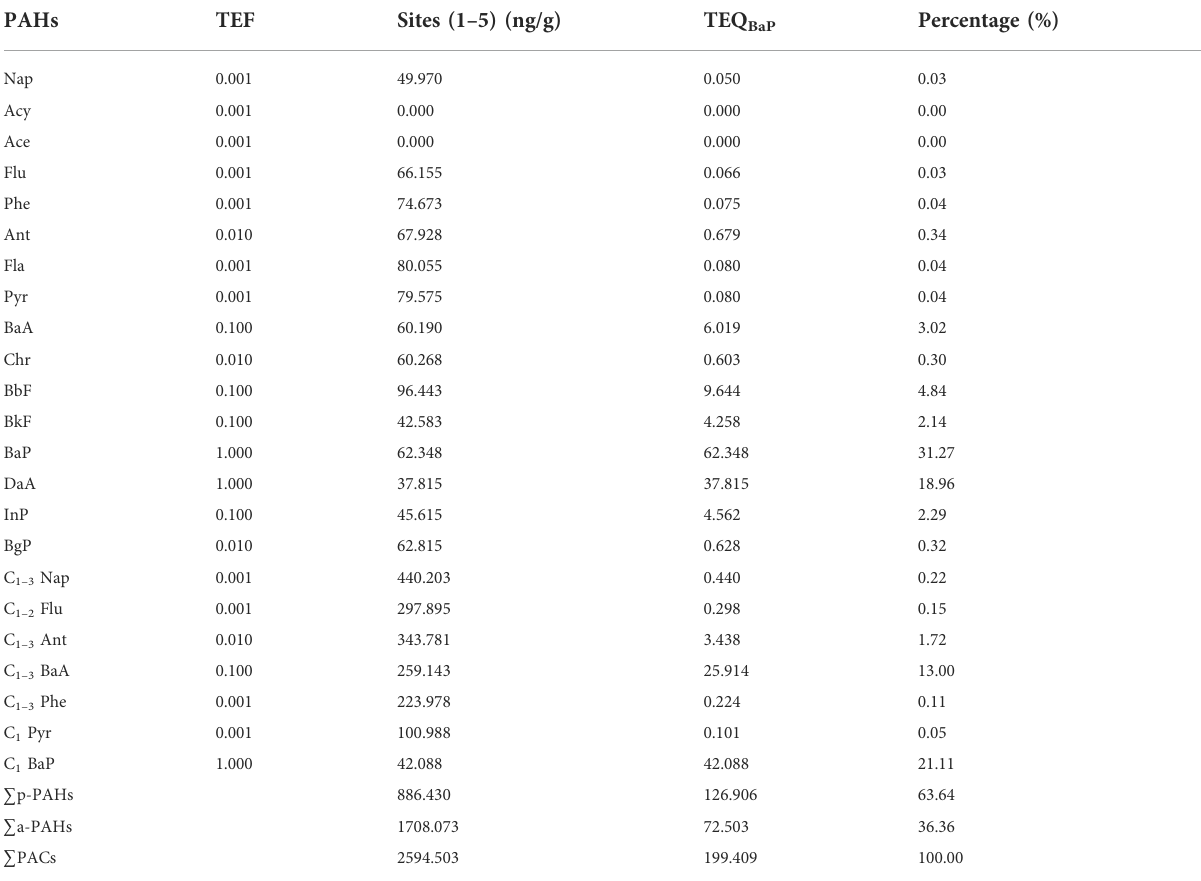
TABLE 5 Toxic equivalent factors (TEFs), and BaP equivalent concentration (BaP eq